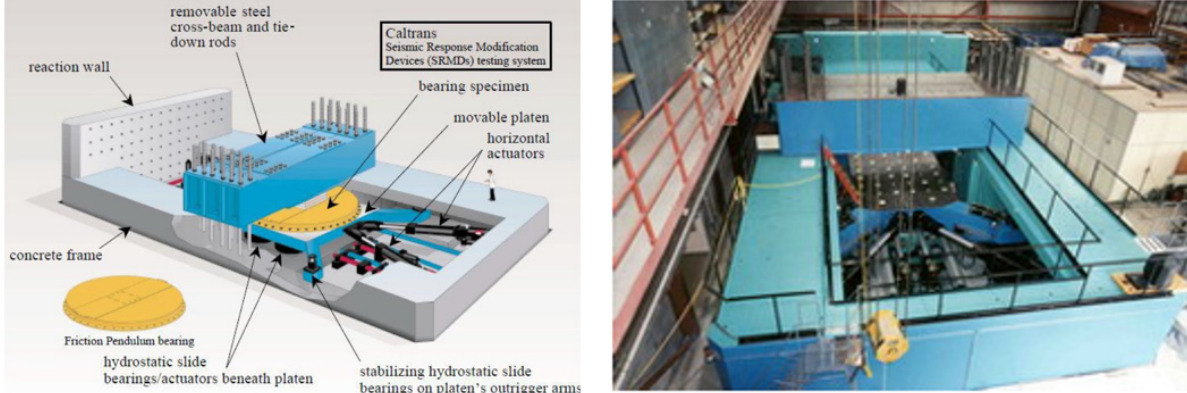
Figure 26. Caltrans Seismic Response Modification Device (SRMD) Test Facility (Courtesy of UCSD).